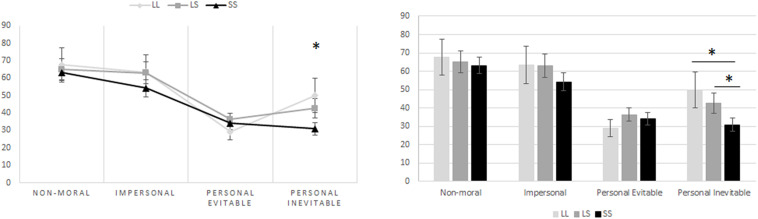
S-allele carriers of the 5-HTTLPR polymorphism exhibited deontological moral judgments for personal inevitable moral dilemmas. The one-way ANOVA revealed that genotype group mean differences were statistically significant for personal moral dilemmas where harm or death to another individual is inevitable [F(2,111) = 3.196, p = 0.045]. Post hoc analyses further showed that in the personal inevitable moral dilemmas, those homozygous for the S-allele (34.27 ± 3.55, mean ± SE, p = 0.048) were less compliant on harming another person, even when harm or death would inevitably occur to this other individual, when compared to those homozygous for the L allele (51.92 ± 9.16, mean ± SE, p = 0.048). In the same manner, the difference between the means of those homozygous for the S allele and those with heterozygous alleles (L/S) (46.15 ± 4.64, mean ± SE, p = 0.047) was also significant. Nevertheless, there was no statistically significant difference between the means of those with heterozygous alleles (L/S) and those with homozygous L alleles (p = 0.535). Furthermore, there is a statistically significant linear association between genotype group (number of risk allele “S”) and personal inevitable moral dilemmas, when controlling for age and gender [F(3,110) = 3.256, p = 0.019, R2 = 0.082]. Hence, there is a 9.27% decrease in the participants’ willingness to answer positively to perform an action that would have as an outcome harm or death (even when such harm or death is in the end inevitable) to another person, as a function of a one increase in S alleles being carried.